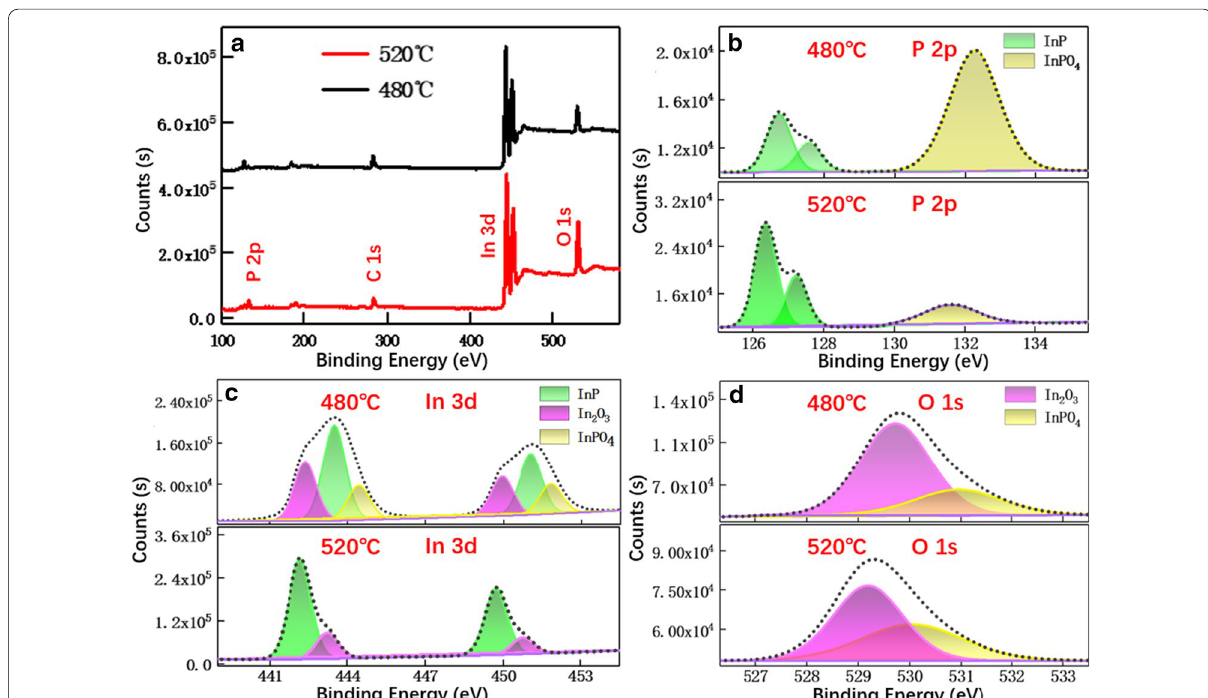
Fig. 2 XPS comparison of InP nanowires surface grown at temperature 480 °C and 520 °C. a Survey spectrum, high-resolution XPS spectra of the b P-2 p , c In-3 d , d O-1